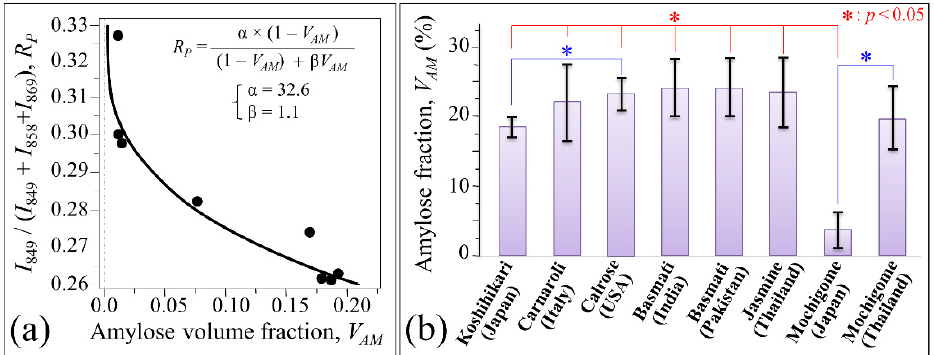
Figure 4. ( a ) Calibration curve relating the spectral intensity ratio of C–O–C bending sub-bands, R P = I 849 /( I 849 + I 858 + I 869 ), to the amylose volume fraction, V AM ; least square fitting equation and related constant in inset. In ( b ), average values in percents of amylose fractions measured in Japanese and international rice cultivars (standard deviations computed over 30 measurements at different locations per each type of rice) and statistical validation according to Student’s t-test (cf. label in inset).